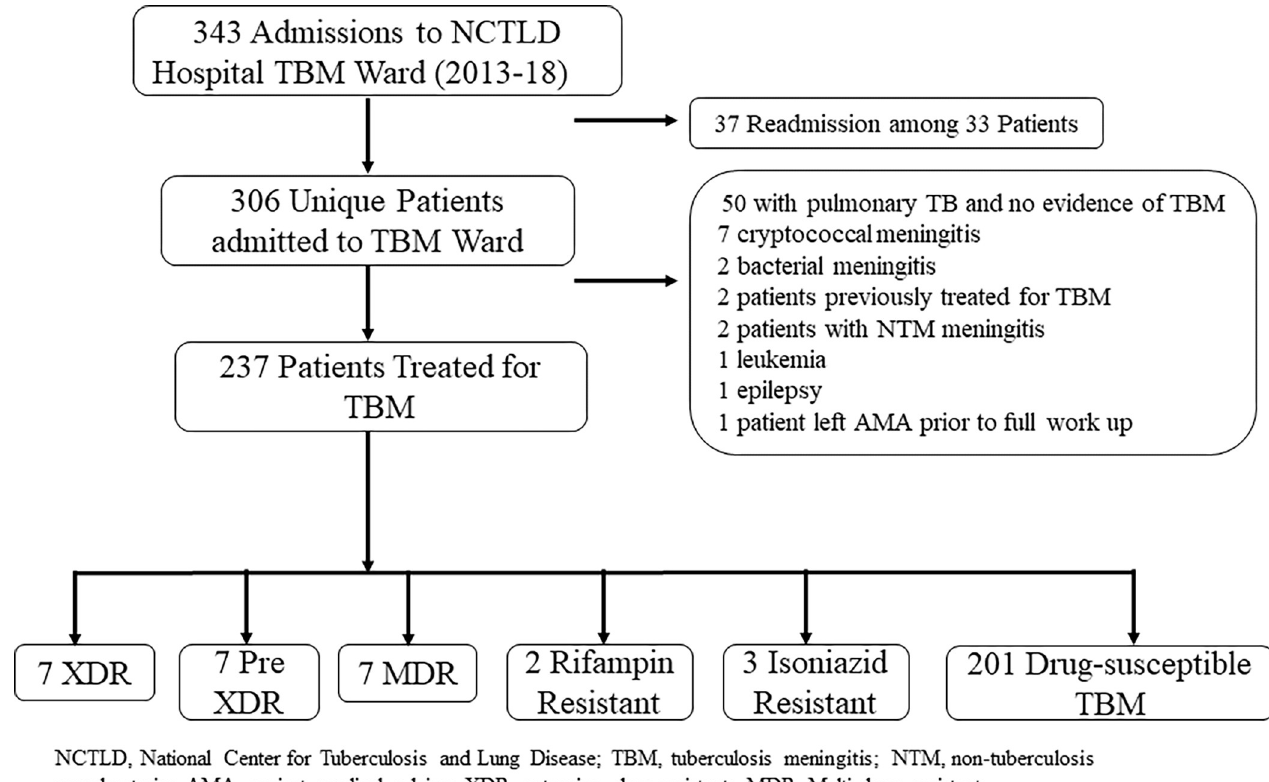
Fig 1. Flowchart of eligible and included patients treated for tuberculosis meningitis by drug-resistance pattern.